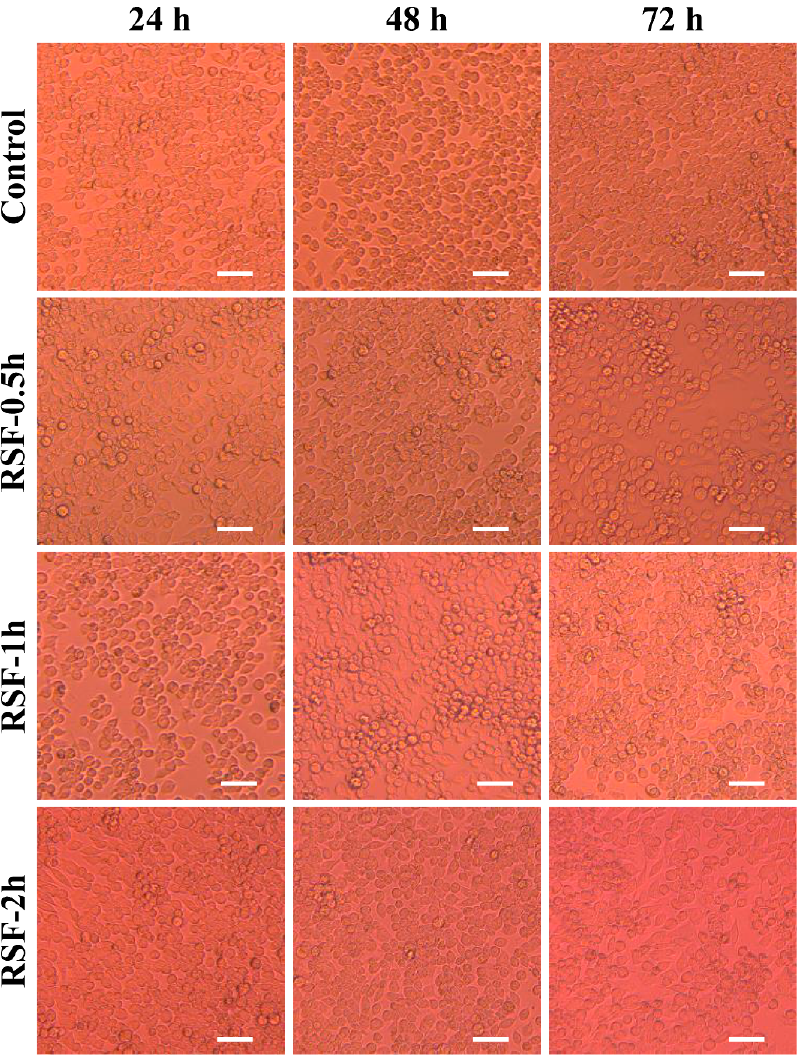
Figure 5. Cell morphology observed under an inverted microscope after co-culture of silk fibroin hydrogel extract with HepG2 cells for 48 h. Scale bar is 100 μ